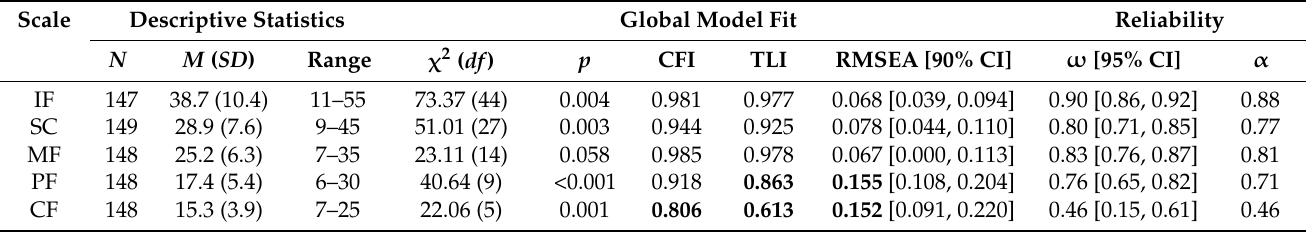
Table 2. Statistics on subscales of Dutch Multifactor Fatigue